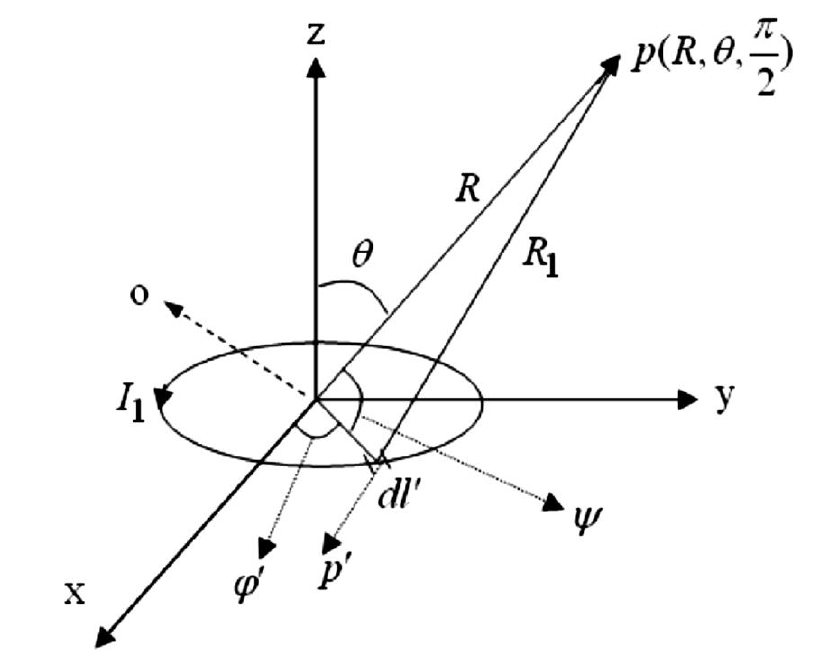
Figure 6. Determination of vector potential of a current carrying ring in any given point P